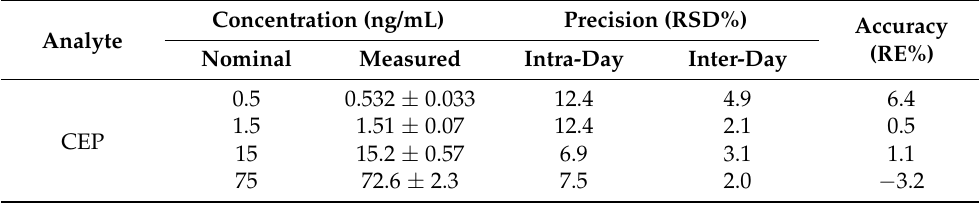
Table 1. Precision and accuracy of the assay for CEP in rat plasma ( n = 6). Concentration (ng/mL) Precision Analyte